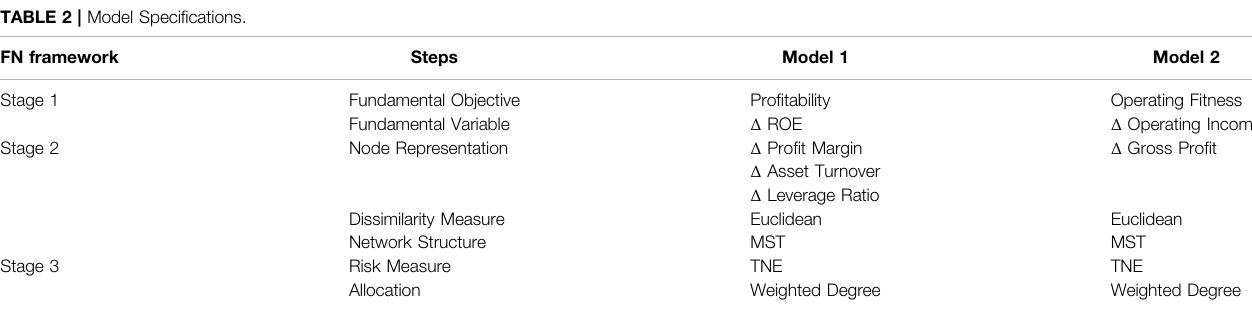
TABLE 2 | Model Speci fi cations. FN framework